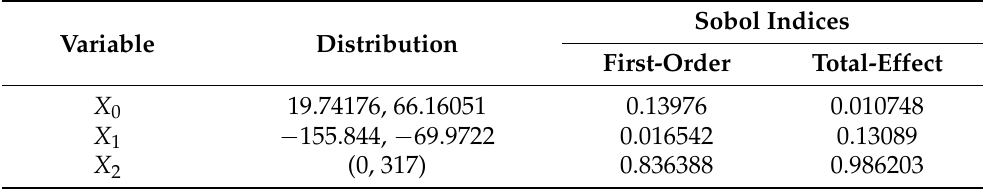
Table 6. First-order and total-effect Sobol indices measuring model sensitivity to parameters in symbolic expression for the estimation of the number of recovered cases for the entire